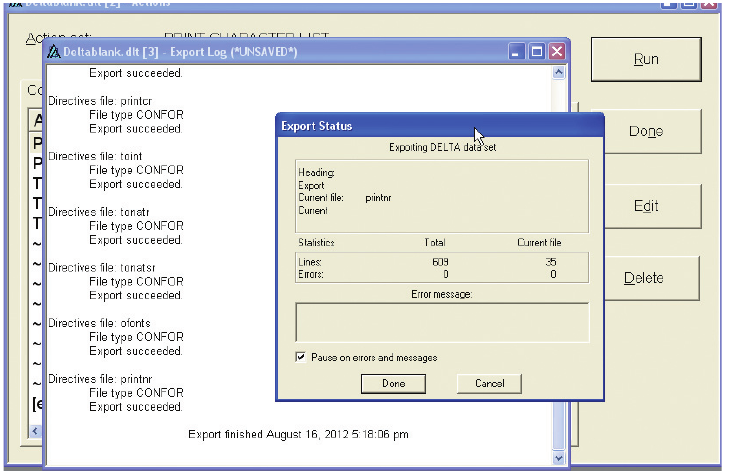
Figure 26. Messages about the course of the export procedures connected to running a directive fi le.